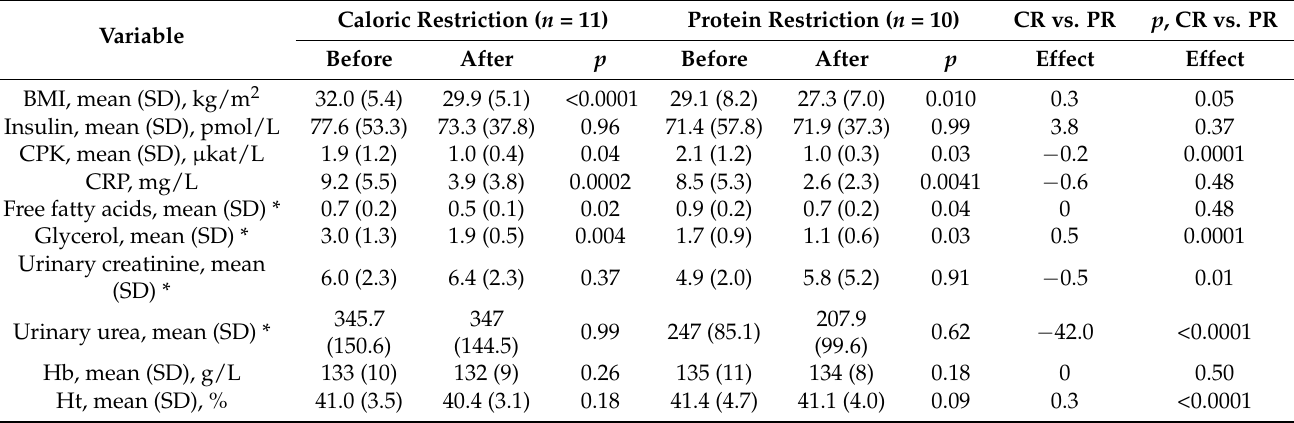
Figure 1. Anthropometric changes after caloric restriction (CR) or protein restriction (PR). ( A ) Body weight (**** p = < 0.0001 and * p = 0.0176). ( B ) Fat mass comparing before and after caloric or protein restriction (*** p = 0.0010 and ** p = 0.0033). ( C ) Free-fat mass comparing before and after caloric or protein restriction ( p = 0.7929 and p = 0.6464). ( D ) Waist circumference comparing before and after caloric or protein restriction (*** p = 0.0009 and * p = 0.0325). ( E ) Hip circumference comparing before and after caloric or protein restriction (** p = 0.0091 and * p = 0.0383). Data are presented in dot-plot format. ANOVA mixed-design analysis of variance was performed. Table 2. Changes in clinical parameters before and after CR and PR.